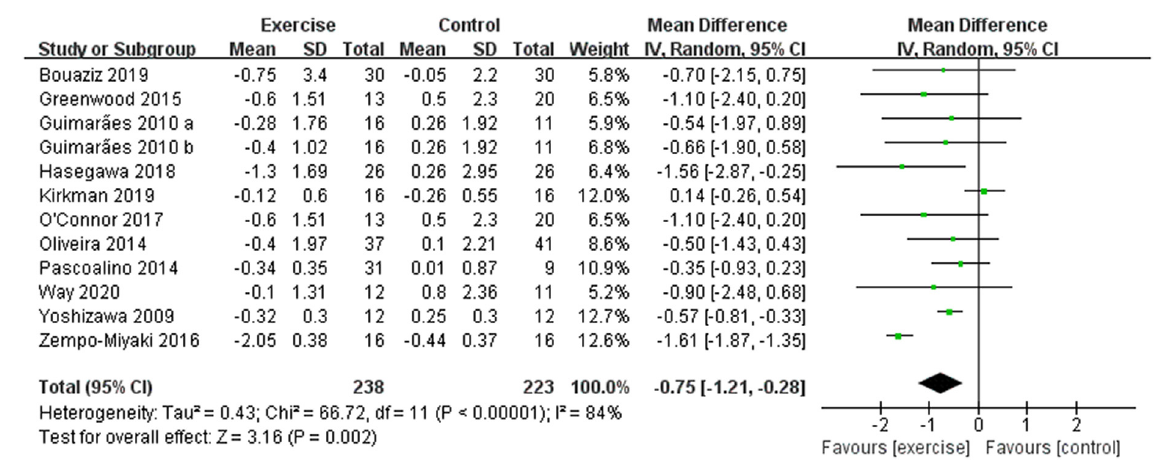
FIGURE4 Meta-analysis results of the effect of aerobic exercise on the PWV of middle-aged and elderly people. The pooled estimates were obtained from random effects analysis. Diamonds indicate the effect size of each study summarized as WMD. The size of the shaded squares is proportional to the percentage weight of each study. Horizontal lines represent the 95% CI and the vertical line represents the overall